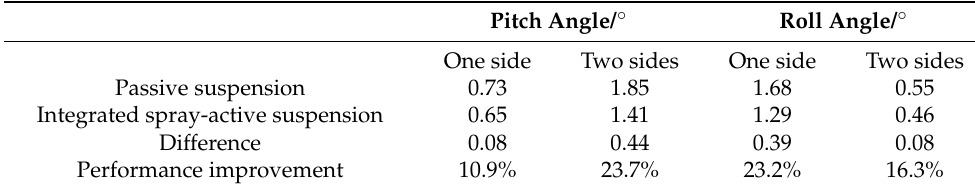
Table 5. Peak – peak value of vehicle attitude.